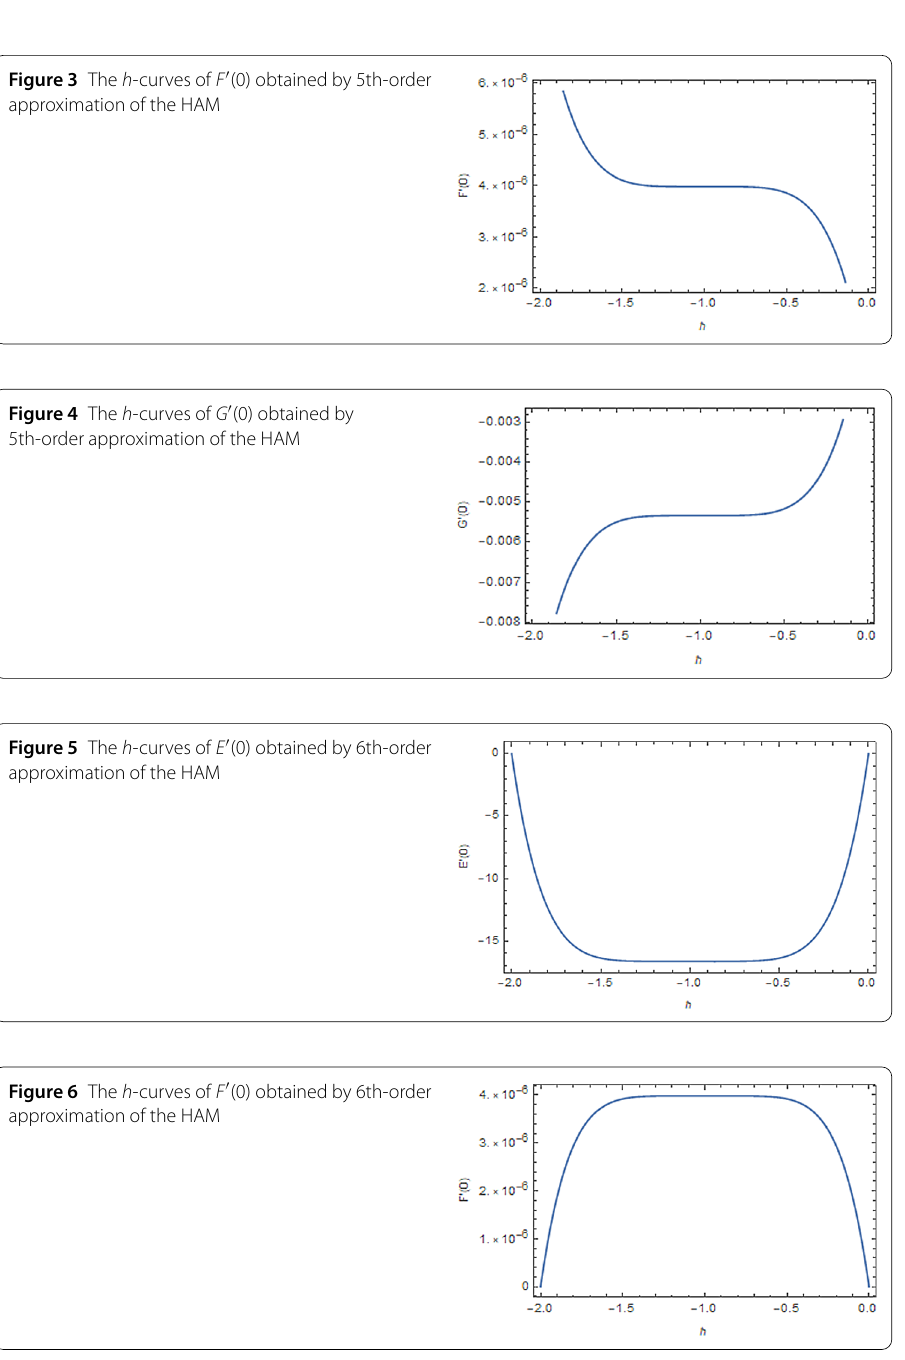
Figure 4 The h -curves of G (cid:10) (0) obtained by 5th-order approximation of the HAM